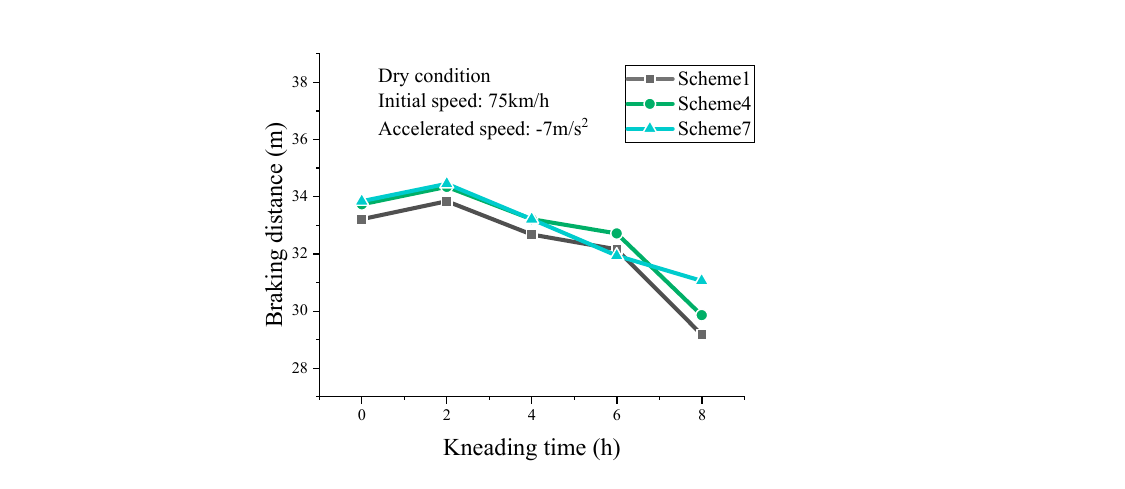
Figure 14. Results for braking distance in dry conditions. Table 7. Results for braking distance on wet pavement